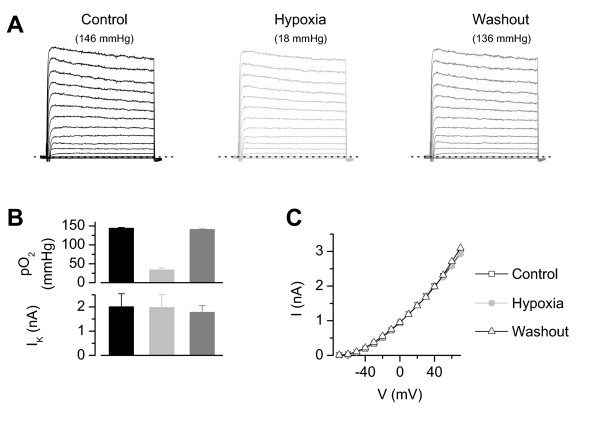
Insensitive voltage-dependent K+ currents in hypoxia. A small group of DRG neurones (22 %) revealed no changes over time in amplitude or kinetic of voltage-gated K+ currents. A) Whole cell recording from a neurone without changes in K+ current amplitude. B) Summary demonstrating an unchanged K+ current (lower panel, n = 7) during different pO2-levels (top panel). C) I-V relation of 7 neurones showed no changes in amplitude of K+ currents over 25–35 min. Bath: choline chloride, pipette: potassium fluoride.